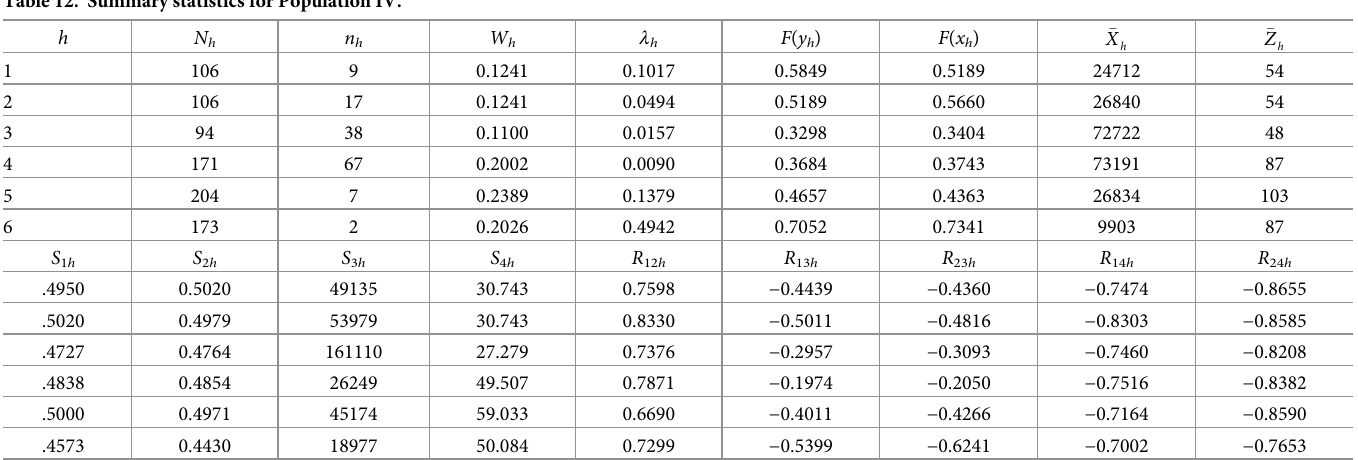
Table 12. Summary statistics for Population IV.